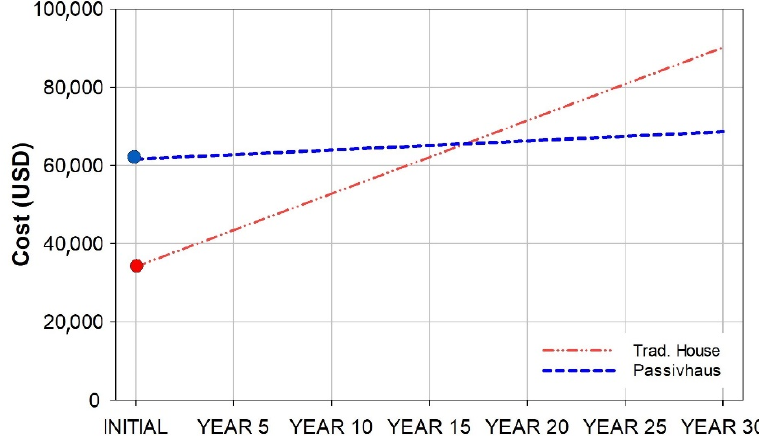
Figure 7. Accumulated annual energy cost of traditional house and Passivhaus. For the initial time, only the construction costs are considered (Appendix B).